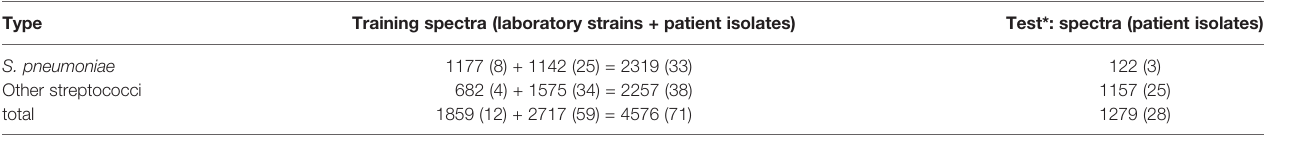
TABLE 1 | Overview of number of aggregated spectra used for modelling and testing. Type